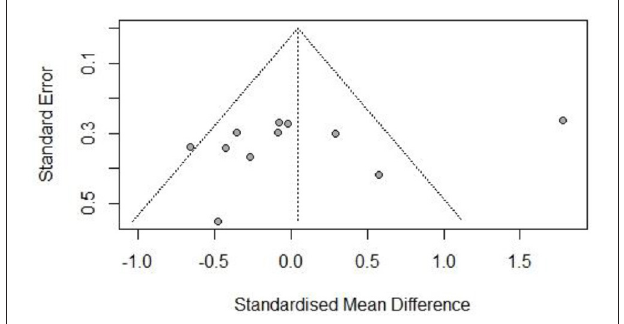
FIGURE 3 | Funnel plot of body mass index (BMI).